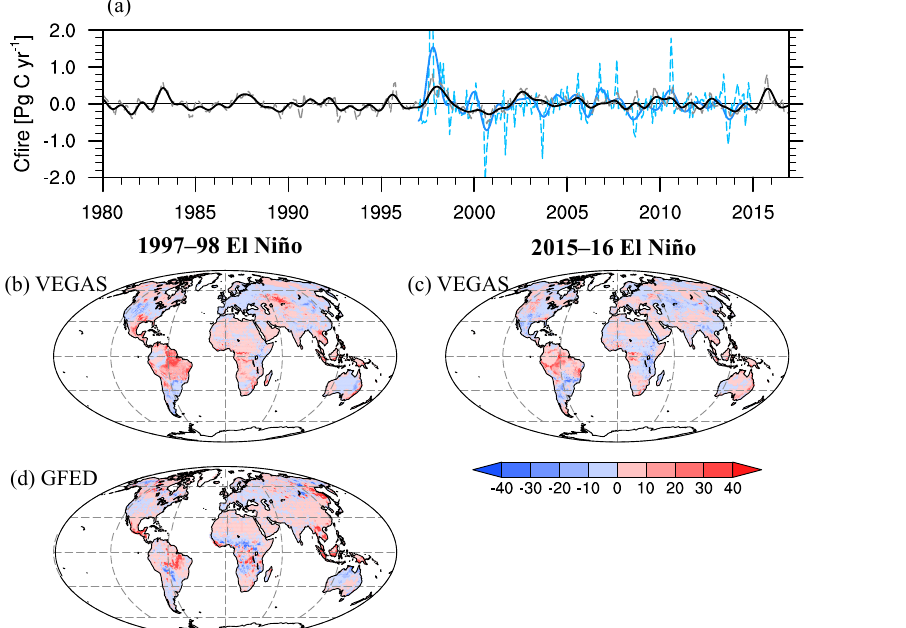
Figure 8. F TA anomalies induced by wildfires. (a) Total global anomalies (PgCyr − 1 ). The dashed gray and solid black lines represent the anomalies simulated by VEGAS, detrended and smoothed by Butterworth filtering, respectively. The dashed and solid blue lines represent the GFED results. (b) Spatial F TA anomaly (gCm − 2 yr − 1 ) during the 1997/98 El Niño in VEGAS. (c) Spatial F TA anomaly during the 2015/16 El Niño in VEGAS. (d) GFED anomaly during the 1997/98 El Niño